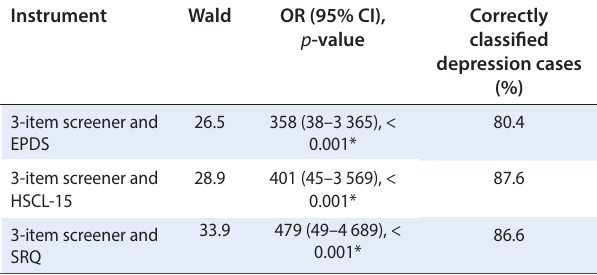
Table 4: Predictive ability of probability combinations of instruments